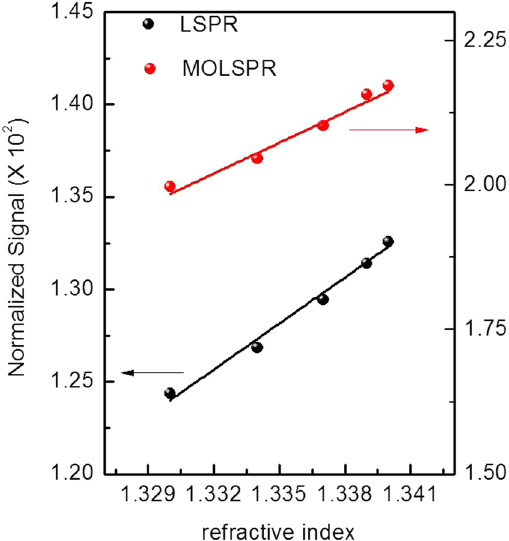
Figure 7. Calibration curves obtained in LSPR and MOLPR configuration relative to bulk refractive index changes at the metal/dielectric